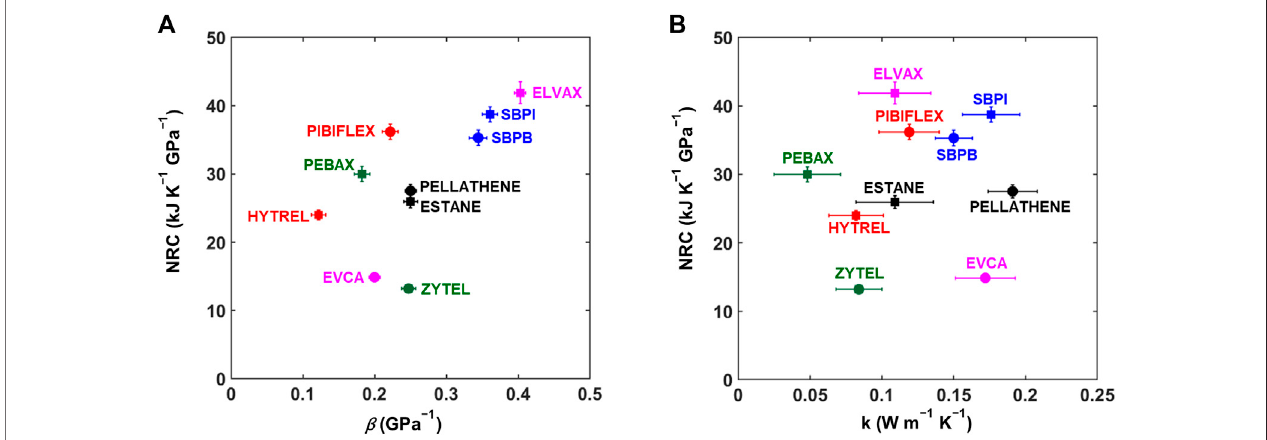
FIGURE5| Mechanical,thermal,andbarocaloricproperties. (A) Normalizedrefrigerantcapacity(NRC,shownfor Δ p =100 MPaand Δ T h − c =65 ° C)andisothermal compressibility ( β at 35 ° C and 50 MPa) of the TPEs tested. (B) NRC and melt thermal conductivity ( k ) of the materials characterized.